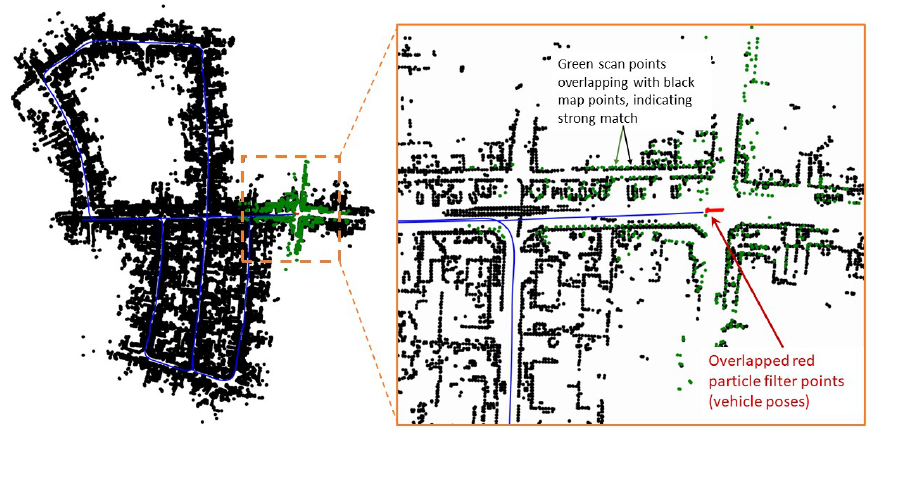
Figure 11. Snapshots of a simulation at k =